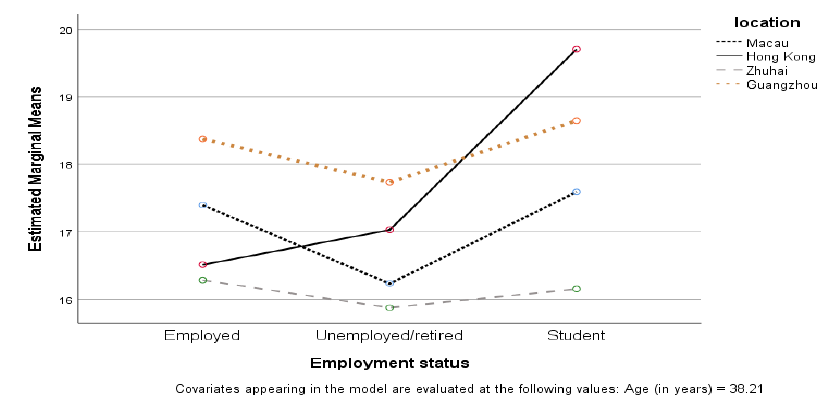
Figure 1. Comparison of Alzheimer’s Disease Knowledge Scale (ADKS) scores among students, and the employed and unemployed participants across four cities.